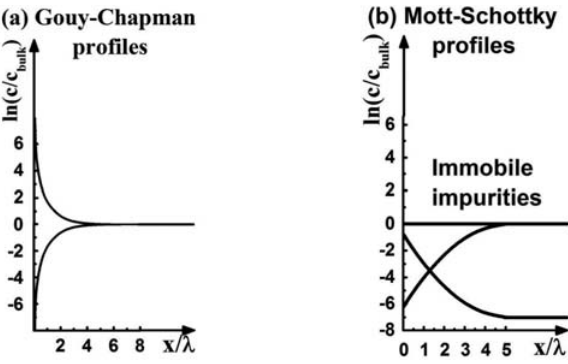
Fig.1. Typical defect profiles in the case of (a) Gouy-Chapman and (b)